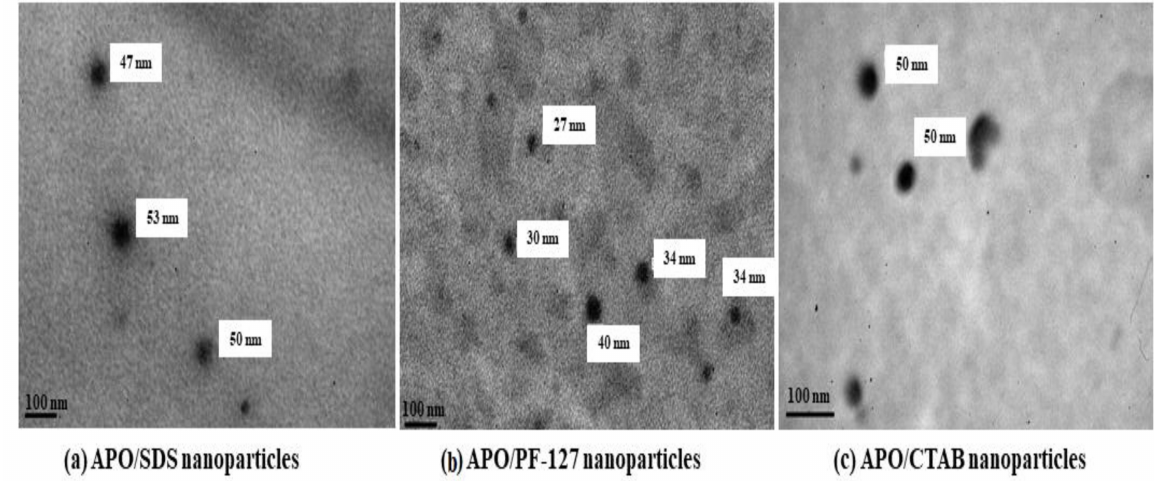
Figure 11. TEM images of the gamma-irradiated APO nanoparticles at different surfactants’ microemulsion system. APO composition of 0.18% in the microemulsion produces a variety of sizes of nanoparticles, such as 47–53 nm in the sodium dodecyl sulphate (SDS), 27–40 nm in the Pluronic-127 (PF-127), and 50 nm in the cetyltrimethylammonium bromide (CTAB) microemulsions. Source: Unpublished data.